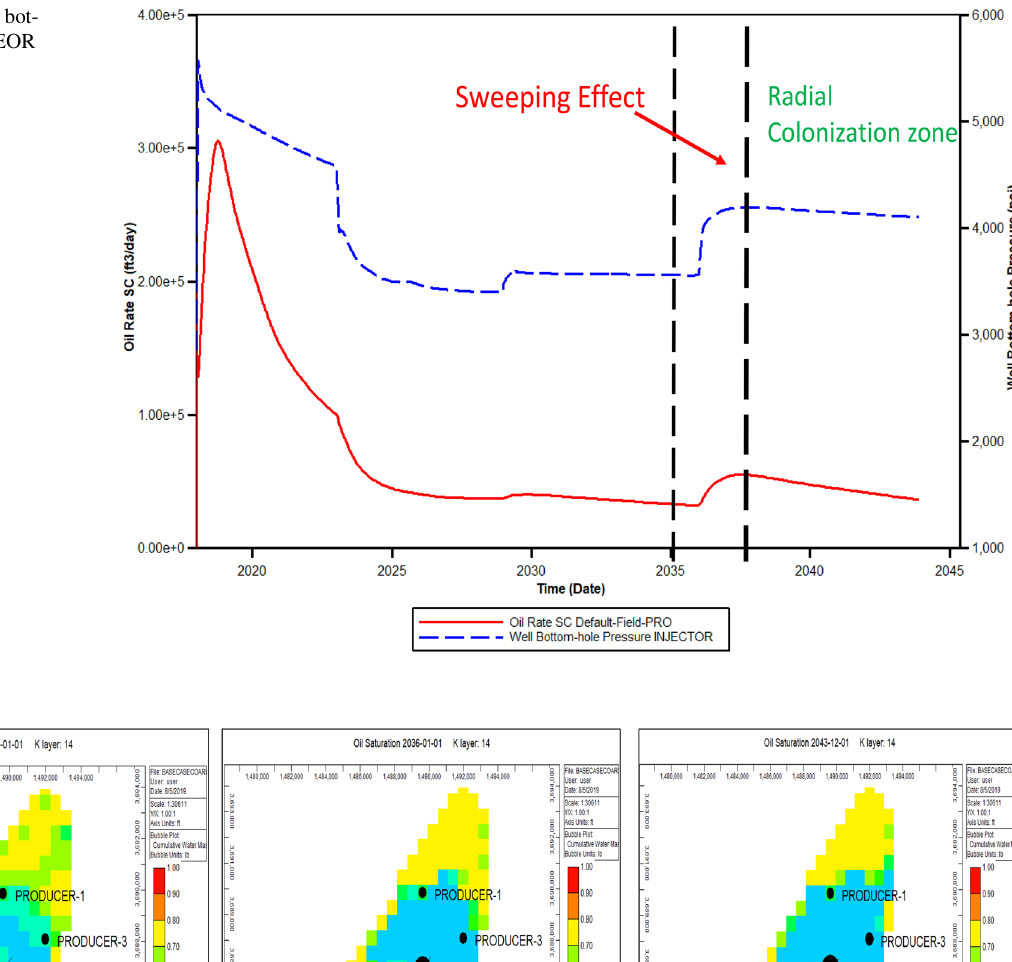
Fig. 16 Oil rate and well bot- tom hole pressure for MEOR